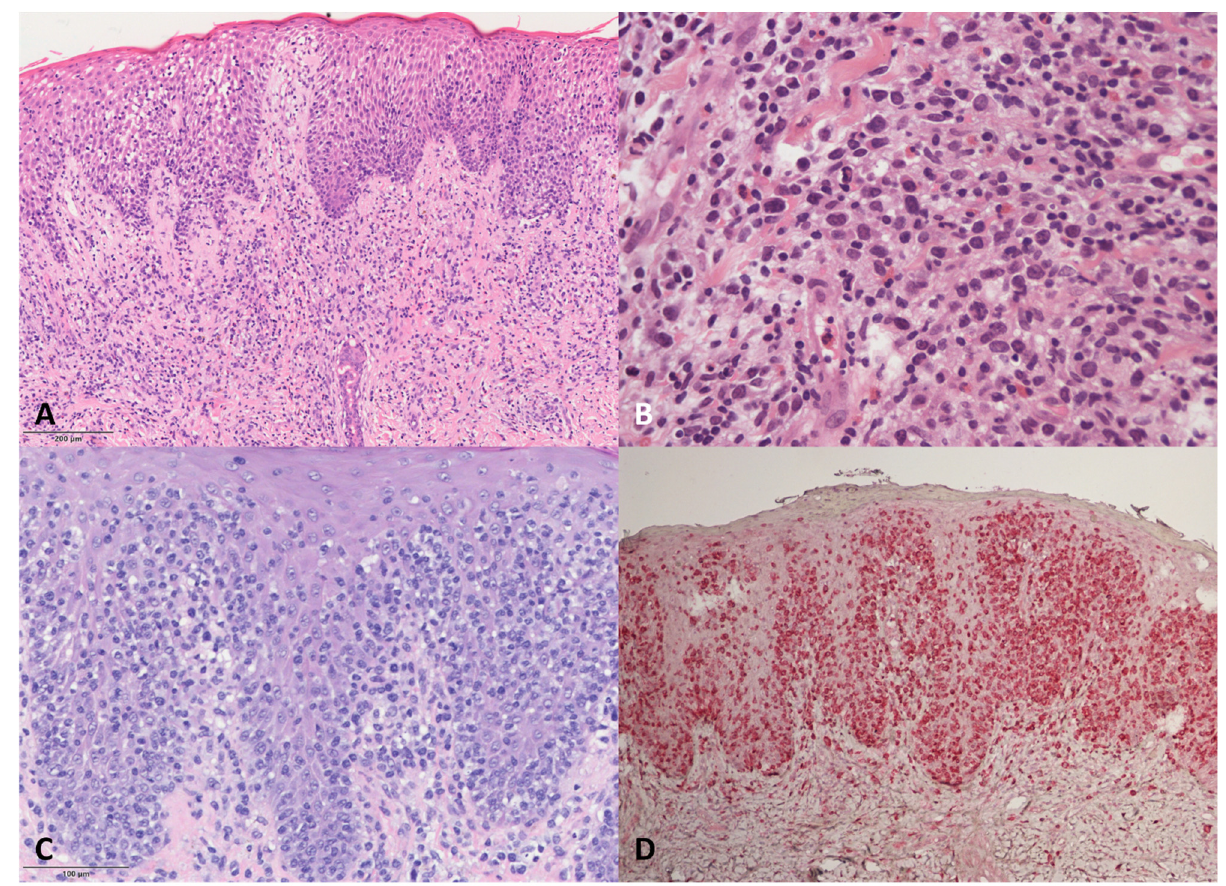
Figure 2. Histological features of the DE-GDTCLs. ( A ) Medium-to-large pleomorphic cells with hyper-convoluted nuclei infiltrating the epidermis and the superficial dermis (plaque). Haematoxylin and eosin (H&E), 100×. ( B ) Nodular infiltrate with medium-to-large pleomorphic neoplastic cells showing mitotic figures mixed with eosinophils and blasts. H&E, 400×. ( C ) Marked epidermotropic infiltrate of medium-sized hyperchromatic lymphocytes and some blasts. H&E, 200×. ( D ) TCR δ staining of the lesions shown in C. Immunophosphatase, 200×.